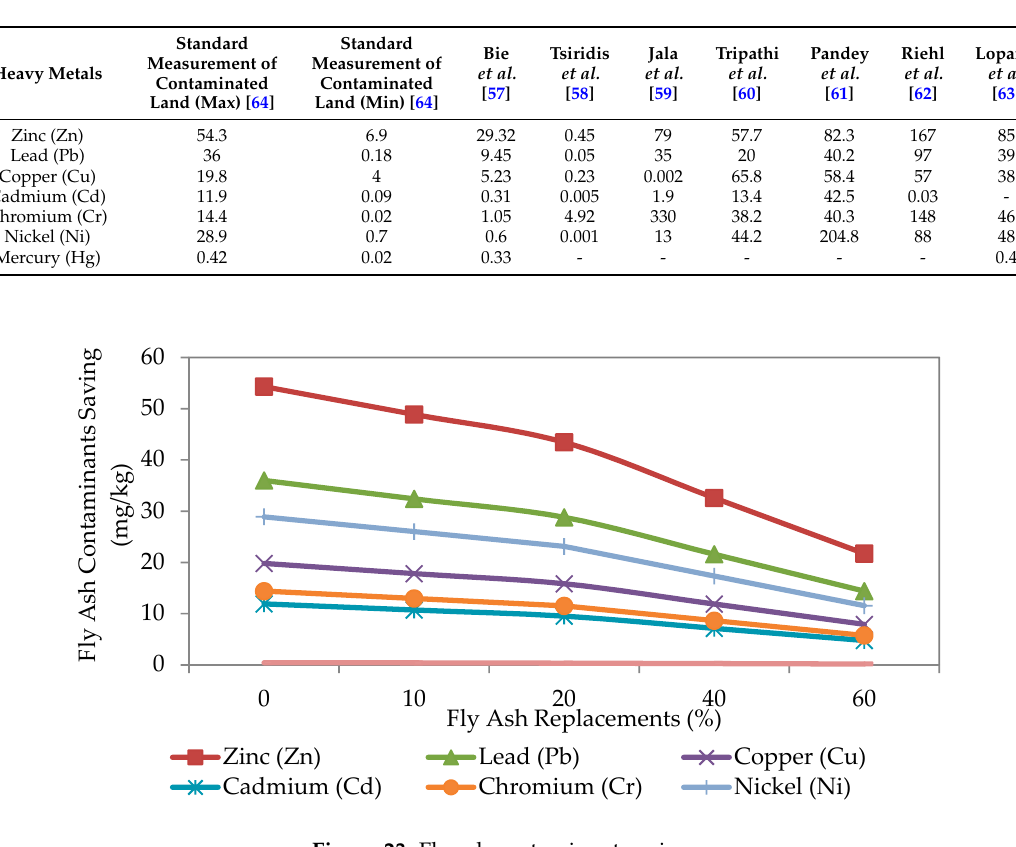
Figure 23. Fly ash contaminant savings.